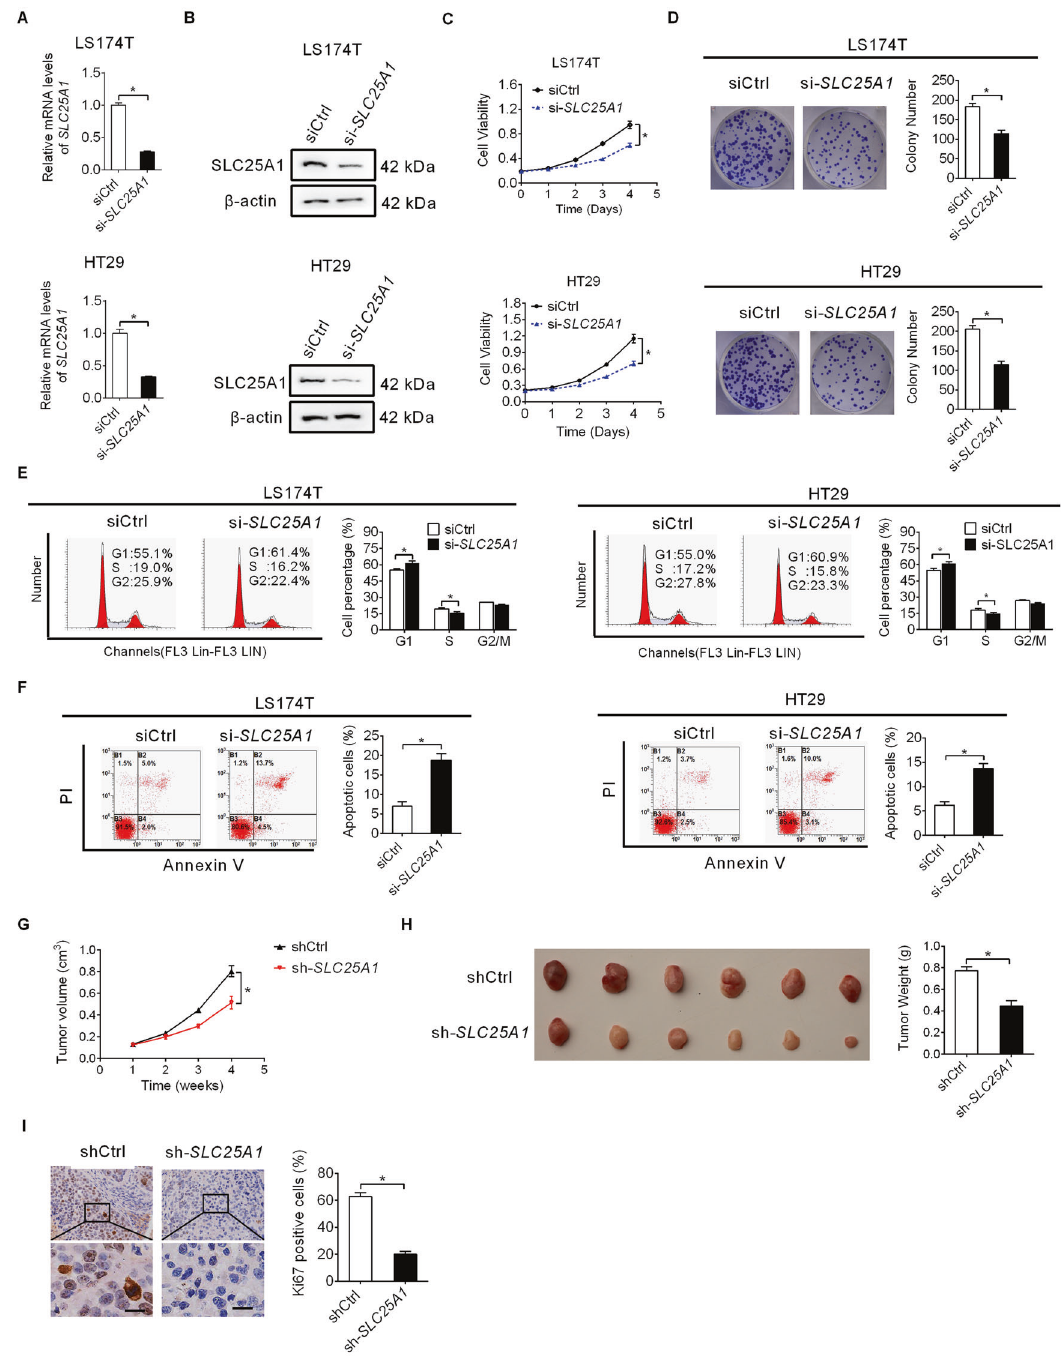
Fig. 2 SLC25A1 promotes CRC cell growth in vitro and in vivo. A , B Knockdown of SLC25A1 was con fi rmed by qRT-PCR and western blot assays in LS174T and HT29 cells. C Cell proliferation was determined by MTS assay in LS174T and HT29 cells with SLC25A1 knockdown. D Colony formation assay in LS174T and HT29 cells with SLC25A1 knockdown. E , F Cell cycle and apoptosis assays in LS174T and HT29 cells with SLC25A1 knockdown. G , H The sizes and weights of xenograft tumors from nude mice (six mice per group) were compared between SLC25A1 knockdown and control groups. I IHC staining of ki-67 in xenograft tumors from the nude mice. Scale bars, 10 μ